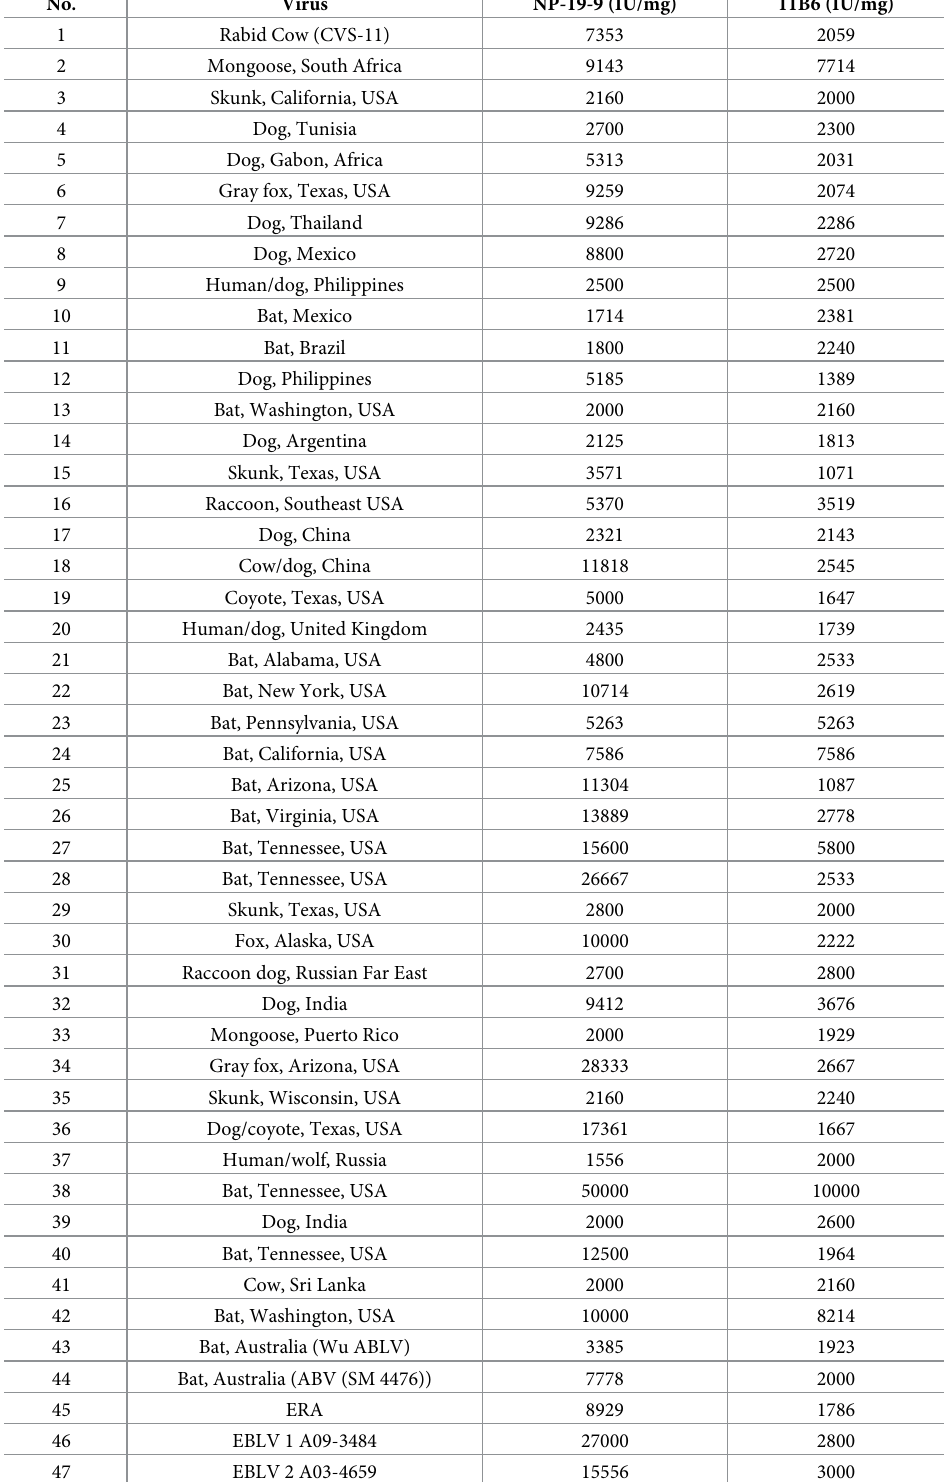
Table 5. Neutralization data using the RFFIT for human mAbs against diverse lyssaviruses.